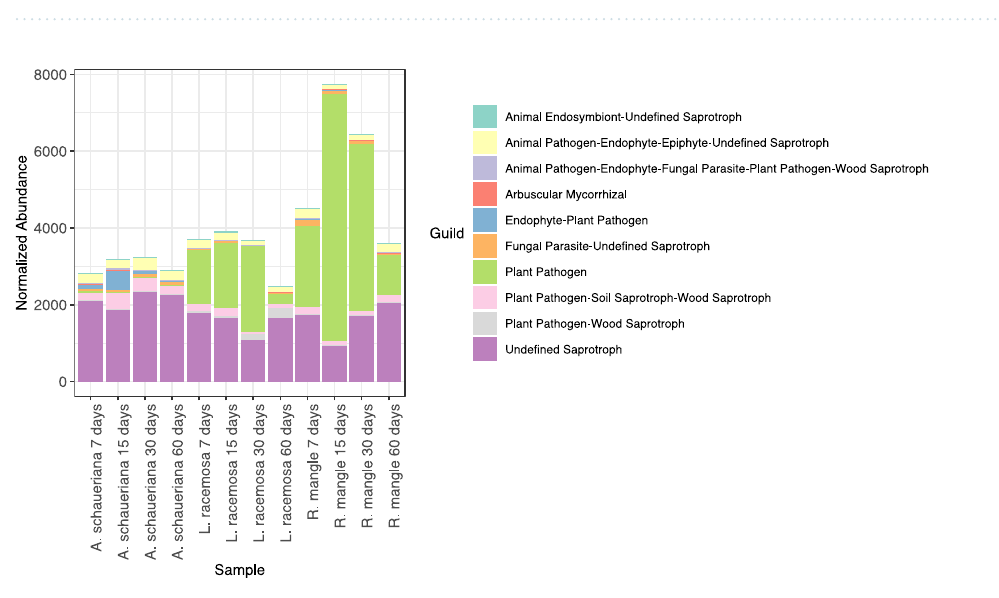
Figure 6. Identification of OTUs belonging to fungal guilds found during the decomposition of mangrove leaves. Identification was performed using